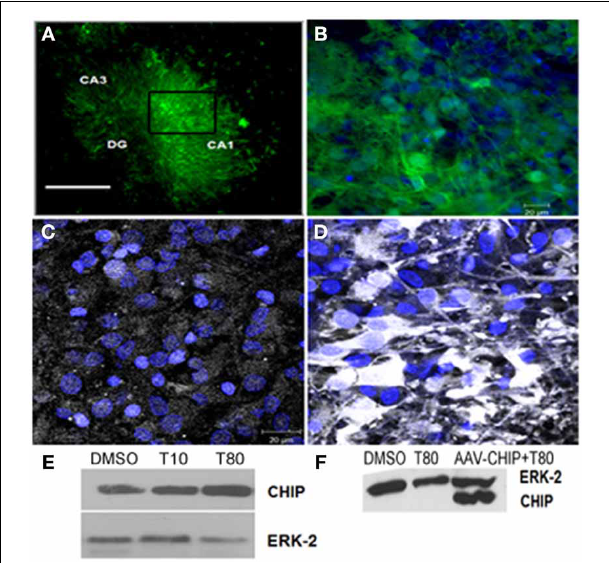
FIGURE 3 | Transgene distribution in hippocampal slices after rAAV8 infection. Hippocampal slices were infected with rAAV8-GFP or rAAV8-CHIP and maintained for 14 days in vitro . (A) Representative photomicrography of slice infected in day in vitro 0 (DIV0) 14 days after rAAV8-GFP infection. 4x Magnification; scale bar: 500 μ m. (B) Higher magnification (40x) of selected region in (A) . GFP fluorescence (green) and TOPRO3 (blue). (C,D) Immunofluorescence for CHIP (white) counterstained with TO-PRO3 (blue) comparing non-infected (C) with rAAV8-CHIP infected slice (D) ; 63x magnification, scale bar: 20 μ m. (E) Western blot for CHIP of Tunicamycin treated slices at 10 (T10) or 80 μ g/mL (T80) compared to vehicles (DMSO). (F) Western blot comparing samples infected with rAAV8-CHIP to non-infected slices. (E,F) Western blot for ERK-2 was used as loading